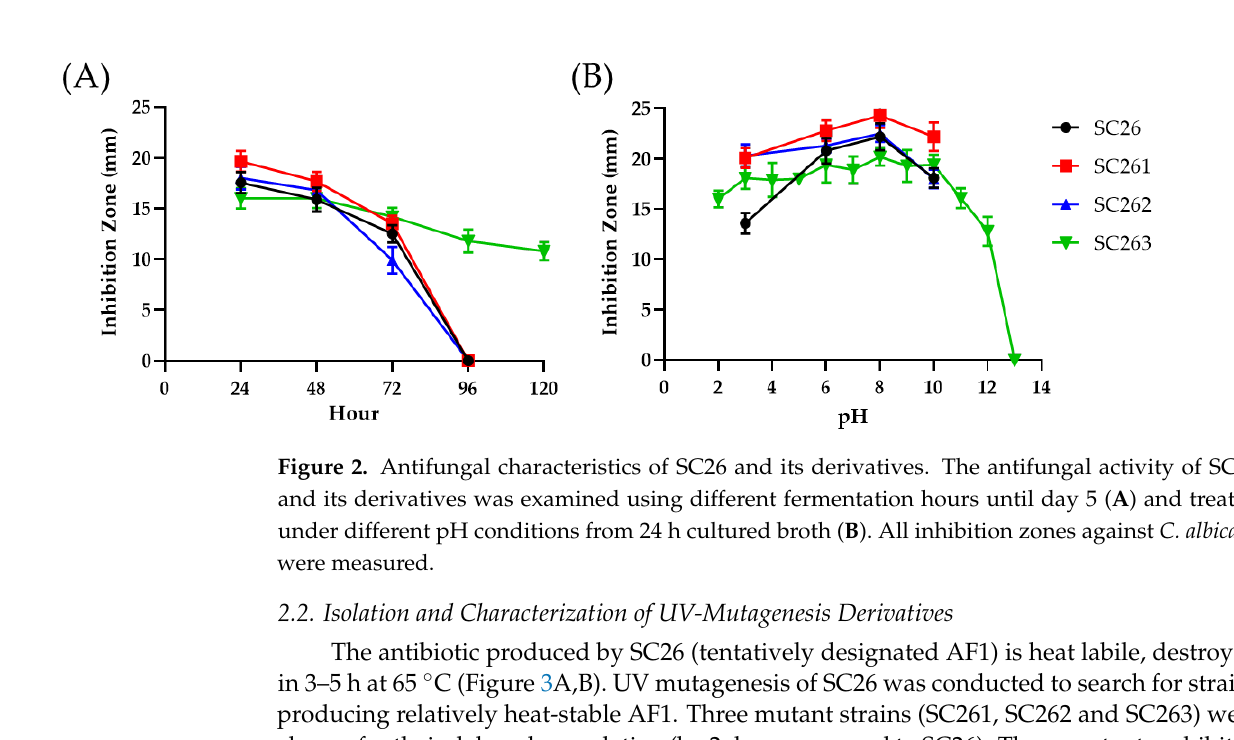
Figure 1. Morphology of SC26. ( A ) Colony morphology of SC26 on YM1 agar after incubation at 30 °C for 6 days. ( B ) Spore chains of SC26 under field-emission scanning electron microscope (FE-SEM). The bar indicates 1 μm.